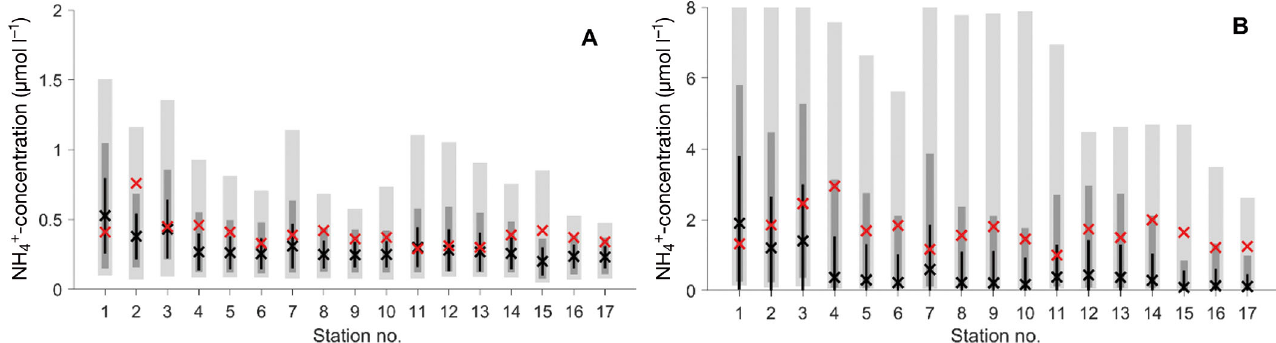
Fig. 3. Comparison between empirical and modeled ammonium concentrations in (A) April and (B) September for each station. Red Xs represent the depth-integrated empirical results. Black Xs represent the median simulated values sampled hourly over the entire month (n = 720 samples for each station), where the black thin lines show the standard deviation, and the thick dark gray lines show the 5 to 95 percentiles. The light gray bars show the range of the minimum to the maximum simulated values at each of the sample points over each